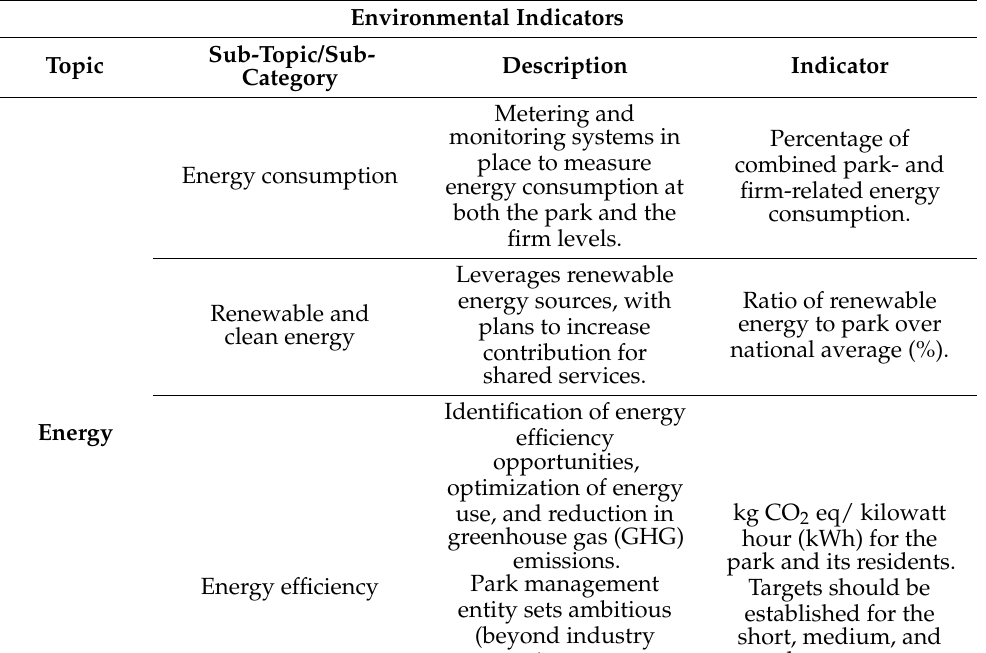
Table 6. A set of indicators to assess and monitor the transformation of the existing business parks into modern types of developments (business parks and eco-industrial